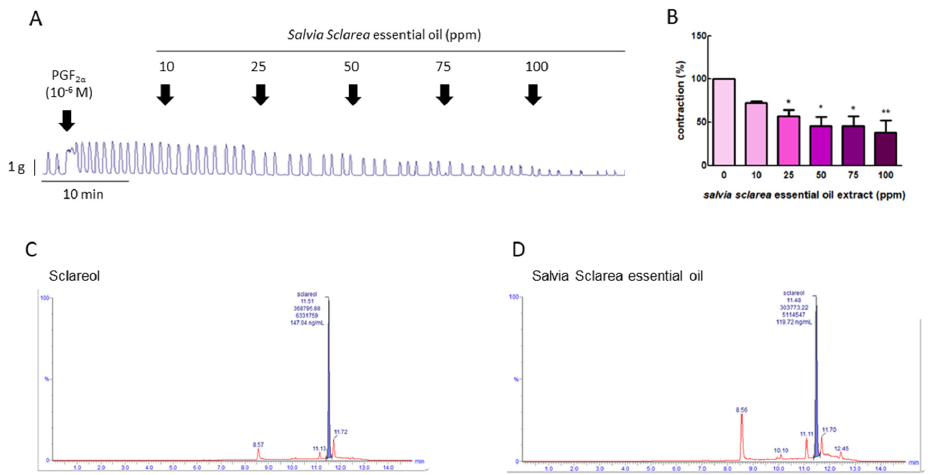
Figure 1. Effect of Salvia sclarea L. essential oil on prostaglandin (PG) F 2 α -induced uterine contraction and total sclareol content in Salvia sclarea L. essential oil. ( A ) Representative recordings of rat uterine tissue were induced with PGF 2 α (10 − 6 M) along with exposure of rat uterine smooth muscles to essential oil (at 10, 25, 50, 75, and 100 ppm.) ( B ) Dose-dependent effects of essential oil on the mean peak amplitude. Each column represents the mean ± standard error of the mean (SEM); n = 4; * p < 0.05, ** p < 0.001 compared to 0. ( C ) Ultra-performance liquid chromatography (UPLC)–MS/MS chromatogram of sclareol standard. ( D ) UPLC–MS / MS chromatogram of Salvia sclarea essential